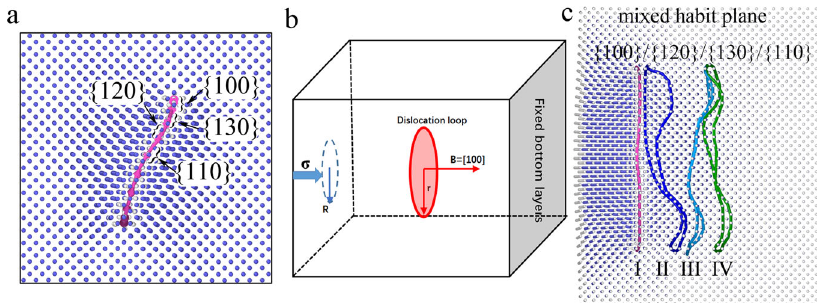
Fig. 3 Habit planes in SAAMD and nanoindentation simulations. a The mixed {100}, {130}, {120}, and {110} habit planes of a <100> loop (shown by the pink curve) during its diffusion in SAAMD simulations. b Schematic of external stress applied on a <100> loop in BCC Fe with nanoindentation method. The loop plane and Burgers vector are shown in the fi gure. The evolution of the loop with simulation time is shown in c from state I to state IV, shown by different colors.